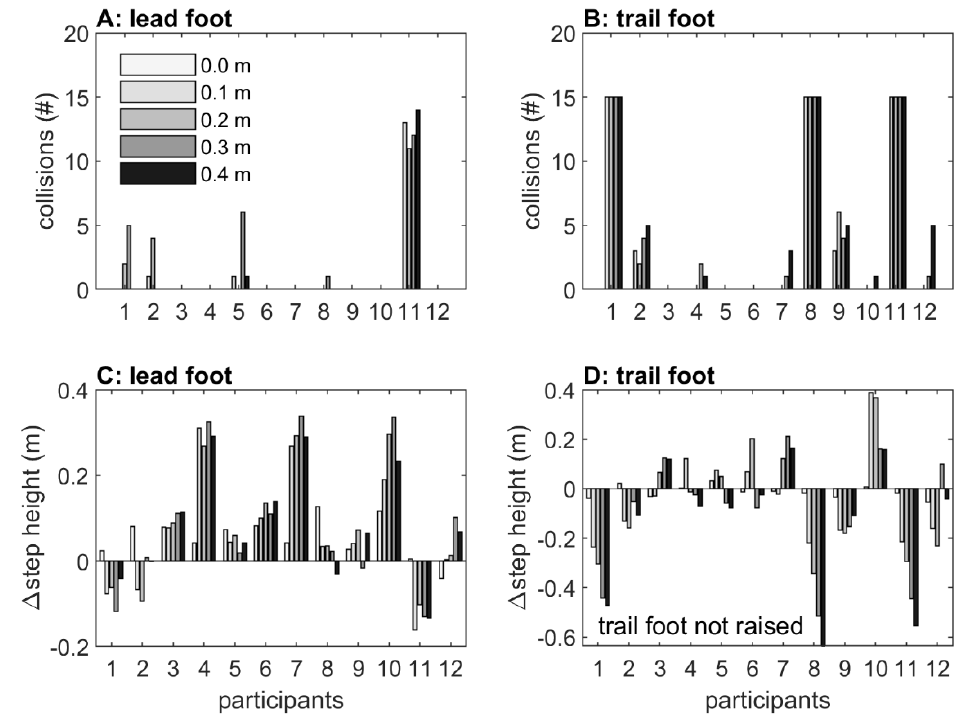
Figure 5. Number of collisions at different obstacle heights of hurdle 1 and 2 combined for every participant in mixed reality for the lead (panel A ) and trail foot (panel B ). The difference in maximum step heights between holographic and real obstacles at different obstacle heights at hurdle 1 for the lead (panel C ) and trail foot (panel D ).